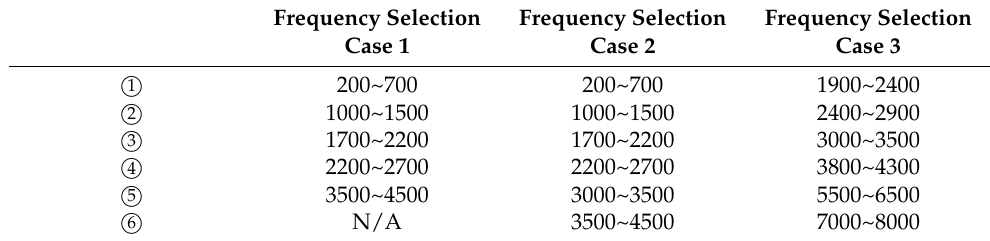
Table 1. Frequency band of interest in each case (Hz).